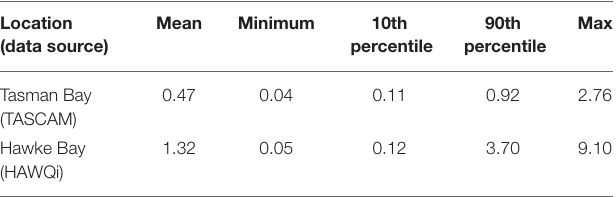
TABLE 1 | Statistics for the two chlorophyll -a datasets (mg/m 3 ) used for algorithm development. Location (data source)